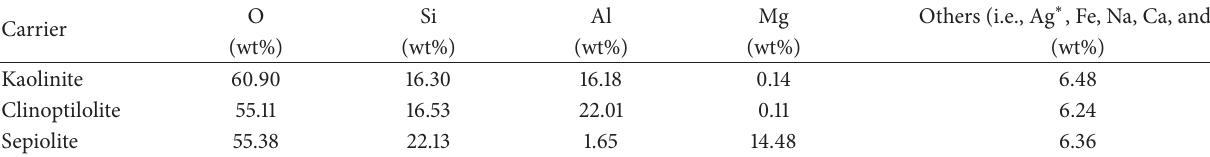
Table 6: EDX analysis results of the chemically treated clays after 30 days of exposure to water media.